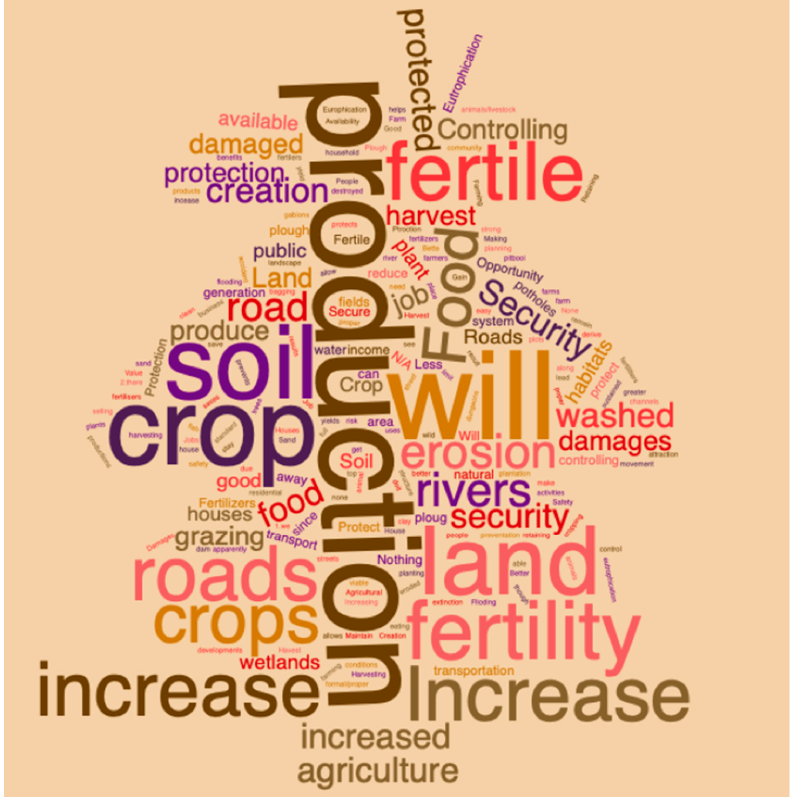
Figure 12. Perceptions on the benefits of controlling soil erosion by communities in the Nzhelele and Levuvhu river catchments. Levuvhu river